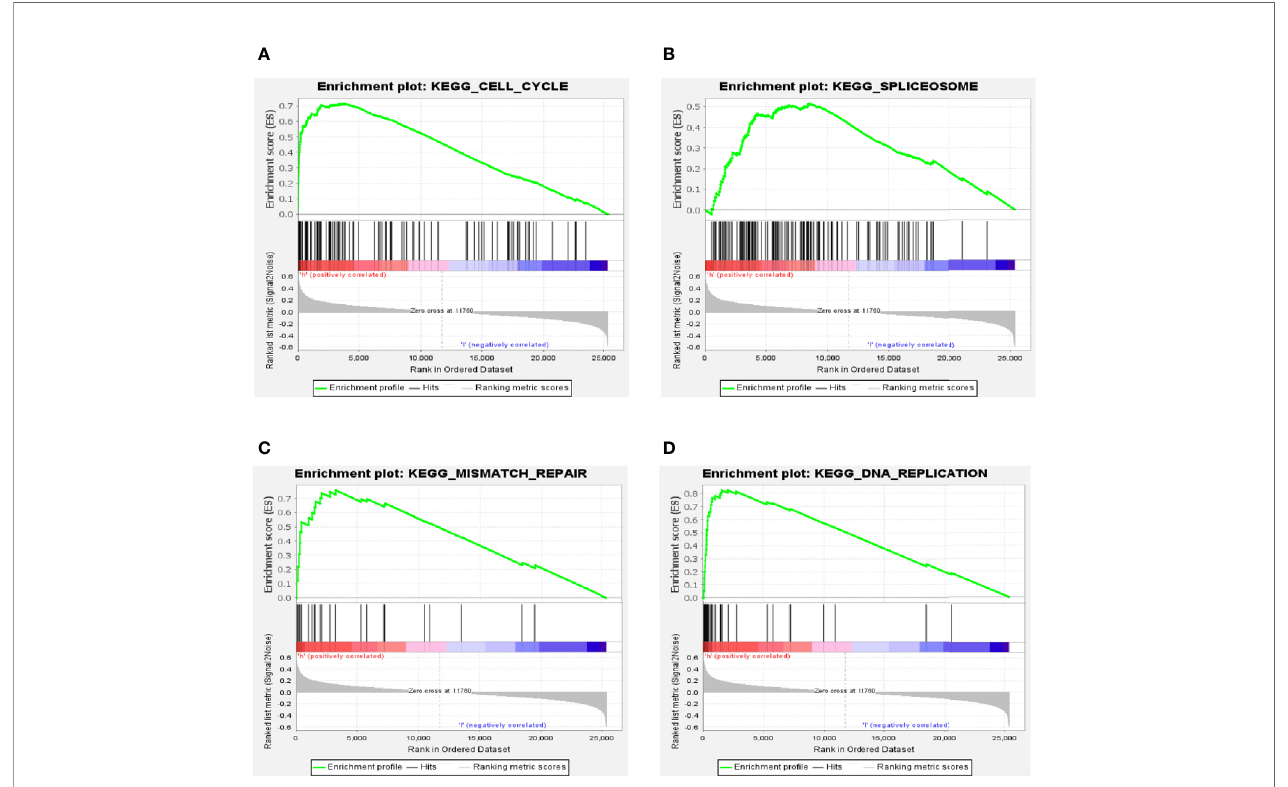
FIGURE 5 | GSEA analysis of the differentially expressed genes between high- and low-RS groups. (A) Cell cycle; (B) spliceosome; (C) mismatch repair; (D) DNA